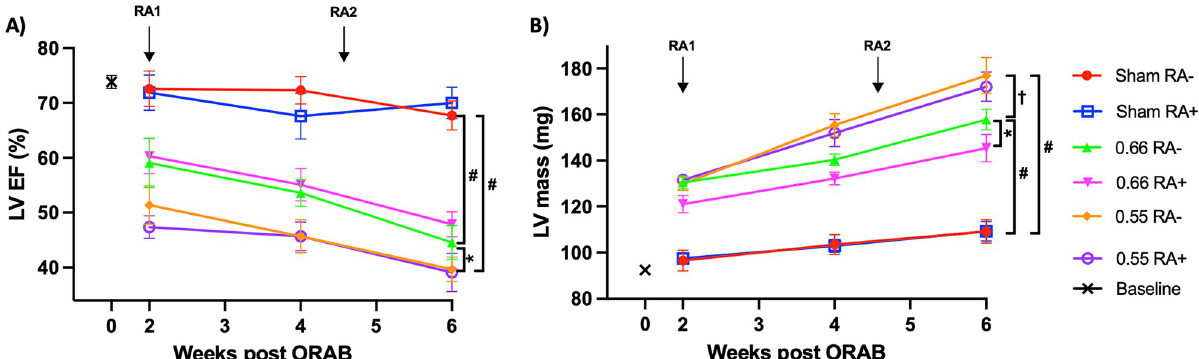
Fig 4. Analysis of LV ejection fraction and LV myocardial mass. MRI assessed LV ejection fraction (EF %; panel A) and LV myocardial mass (panel B) at given time points (n = 42 in total, 7 in each group). Data is presented as mean ± SEM. RA1 = time of establishment of RA phenotype with a sc. injection of mBSA, RA2 = time of re-establishment of RA phenotype with an additional injection with mBSA. Statistical significance was calculated using two-way ANOVA with Bonferroni’s multiple comparisons test. � P < 0.05, † P < 0.01; ‡ P < 0.001, # P < 0.0001. MRI, magnetic resonance imaging; LV, left ventricular; mBSA, methylated bovine serum albumin.